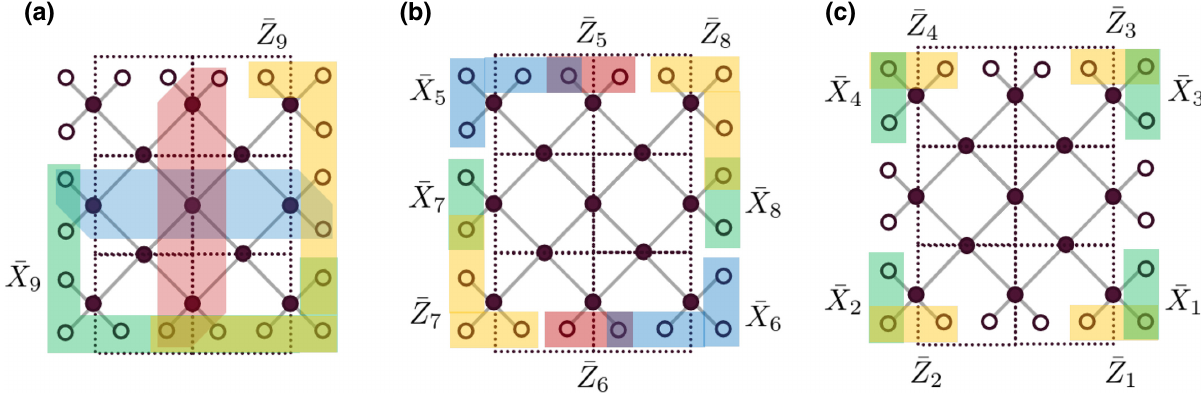
FIG. 21. Starting from a 2D code with bare boundary condition, the boundary degrees of freedom we wish to preserve are denoted by circles whereas the bulk degrees of freedom are solid disks. If we promote all bulk degrees of freedom to logical legs, we then produce the encoding map of a 1D code. (a) One set of the logical (string) operators for the 2D code is given by all Z (red) or all X (blue) acting on the shaded qubits. Their equivalent boundary counterparts are given in yellow and green, respectively. (b),(c) Other logical operators for this example. Blue and green strings denote the tensor product of Pauli X acting on the shaded qubits while yellow and red indicate the product of Z on the shaded qubits. For the 2D code, these strings can also be deformed to act on physical qubits in the bulk. For the dual 1D codes, they act only on the boundary in the way